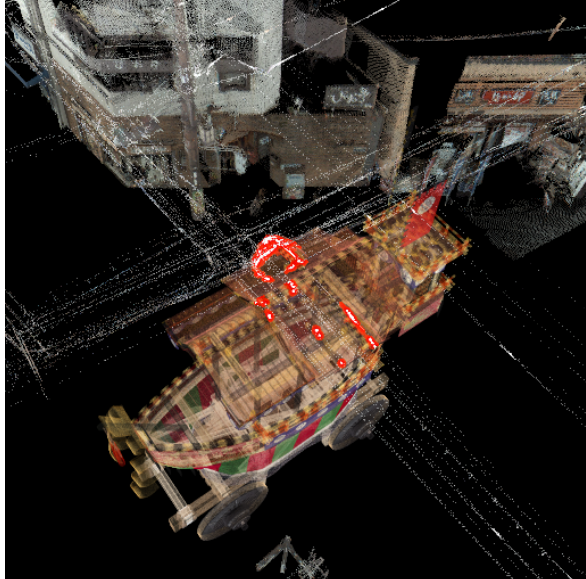
Figure 15. Highlighting collision areas (white) together with their surrounding narrow areas of very high collision risks